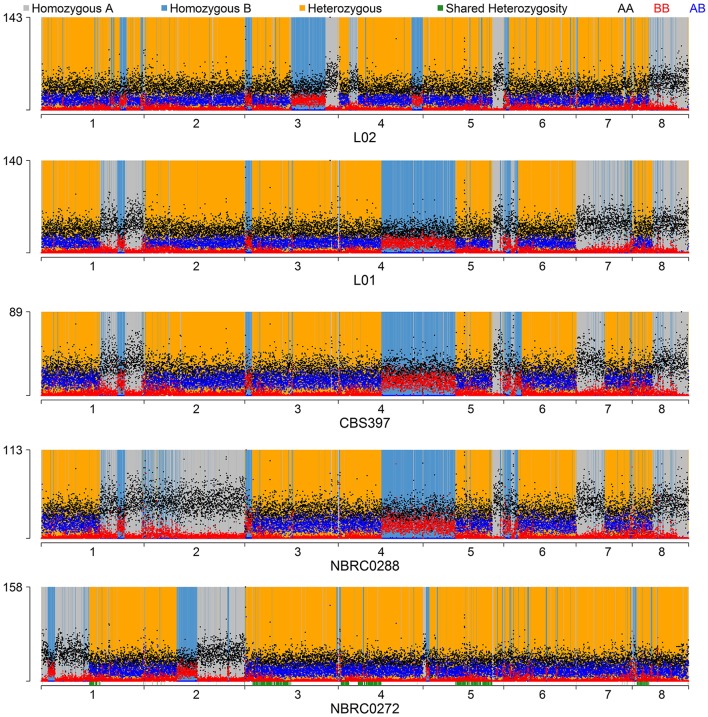
Haplotype assignment in diploid strains. For each 1-kb window through the genome, dots show the number of variable sites in the window with genotypes AA (black dots), BB (red dots), or AB (blue dots). Each window was then classified as either heterozygous (yellow background), homozygous for the B haplotype (blue background), or homozygous for the reference A haplotype (grey background) following rules as described in Methods and Figure S1. The green bars along the bottom axis show the regions (18%) that were heterozygous in all diploids and used for the haplotype phylogeny analysis.